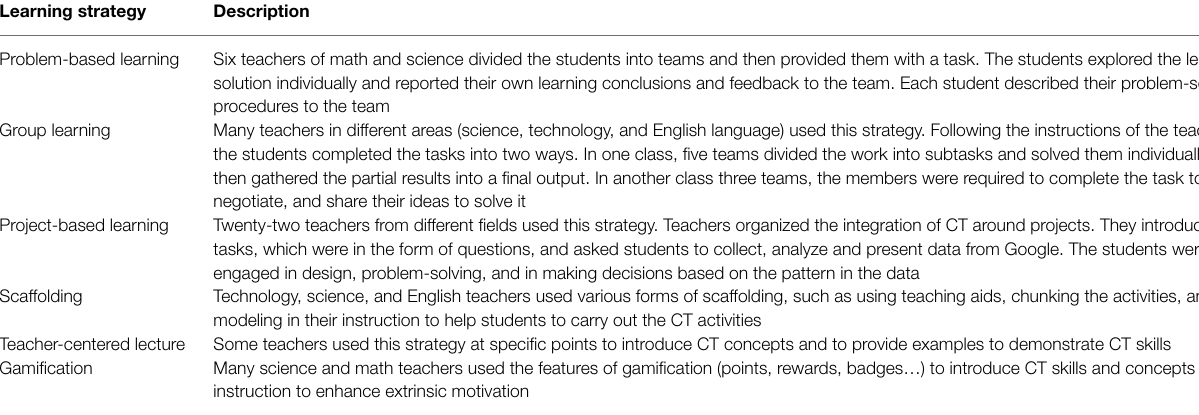
TABLE 3 | Learning strategies used in the